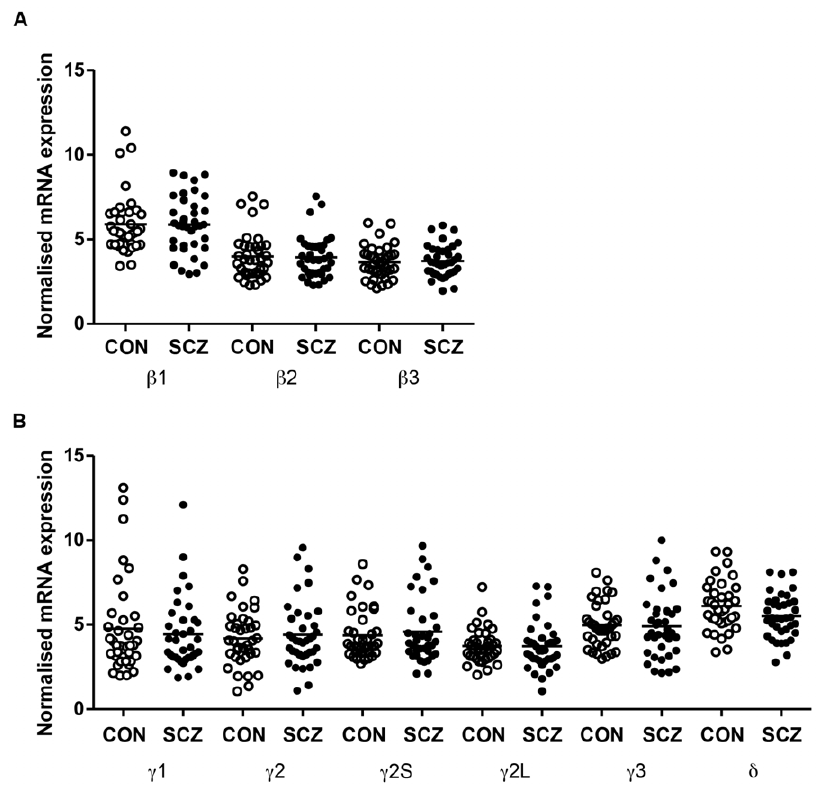
Figure 3. Scatter plots of the normalised expression level of GABA A R mRNA subunits (qRT-PCR) in the DLPFC of control (CON) (n=37) and schizophrenia (SCZ) (n=37) cases. (A) b mRNA subunits and (B) c and d mRNA subunits. Bars represent the means.